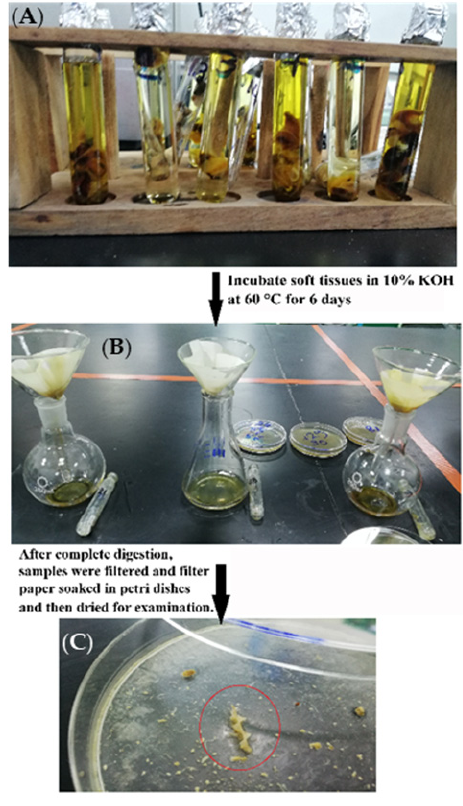
Figure 3. Steps of treatment: ( A ) soft tissues treatment with 10% KOH and incubation at 60 ◦ C for 6 days; ( B ) filtration after complete digestion; ( C ) dryness of filters in Petri dishes for further analyses. Red circle refers to a spiral shape that remained undigested after the whole digestion of R. decollata soft